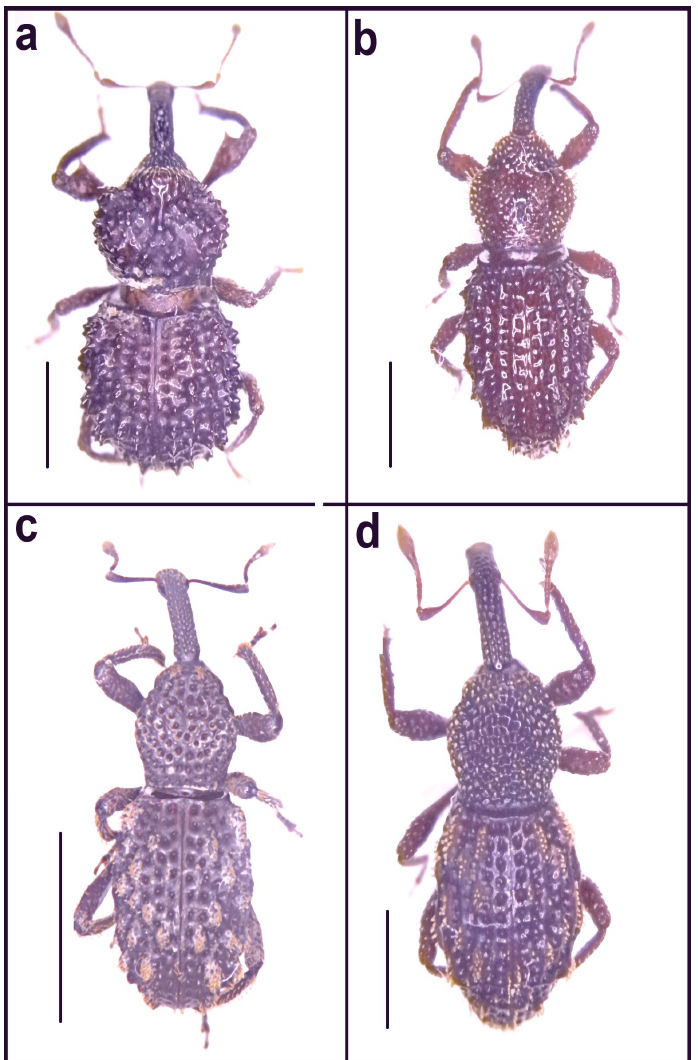
Figure 16. Weevils from Otonga. Species IndVal of the primary forest. Species “h3” ( a ); species “i3” ( b ). Species IndVal of the secondary forest. Species “d1” ( c ); species “m1” ( d ). Bar: 1 mm ( a , b , d ); 5 mm ( c ).